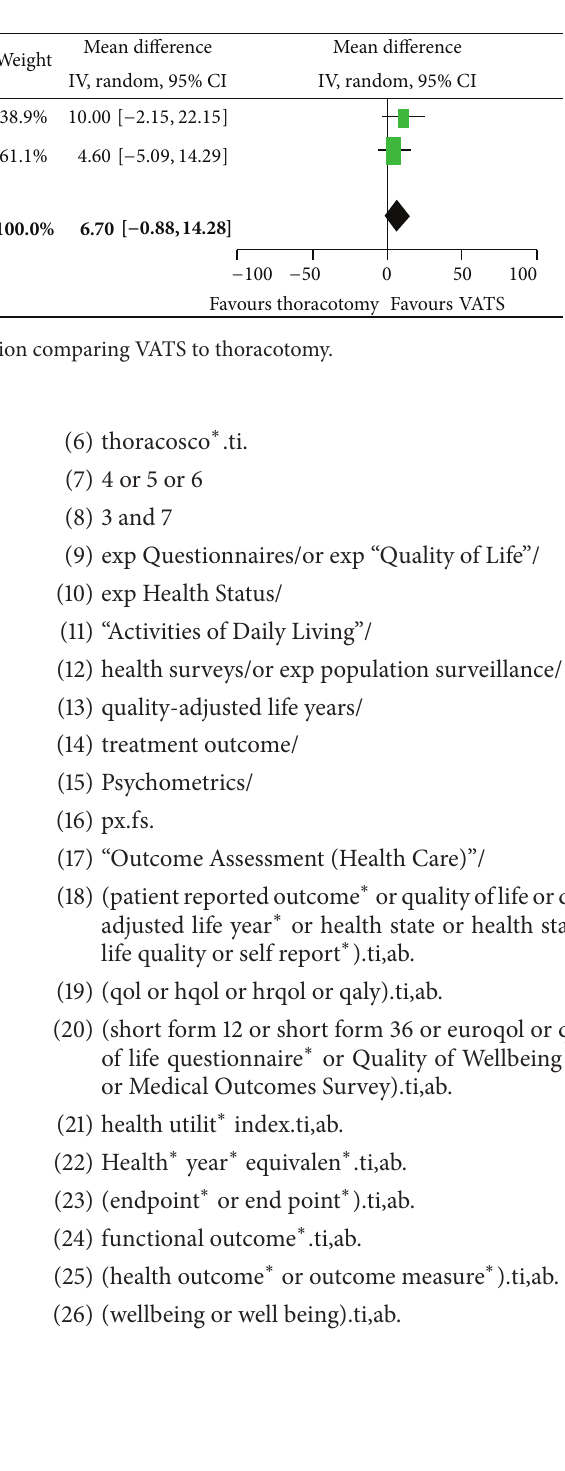
Figure 3: Forest plot for Physical scale comparing VATS to thoracotomy.